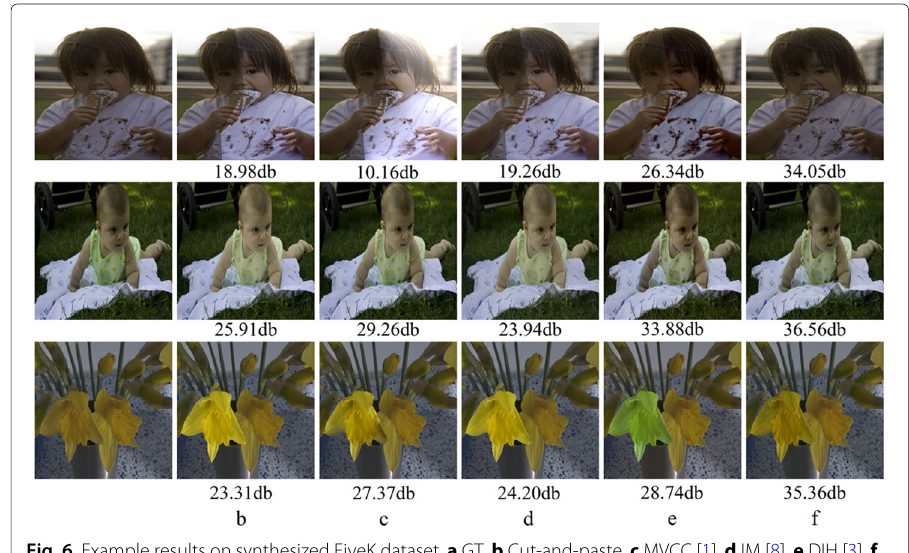
Fig. 6 Example results on synthesized FiveK dataset. a GT. b Cut-and-paste. c MVCC [1]. d IM [8]. e DIH [3]. f